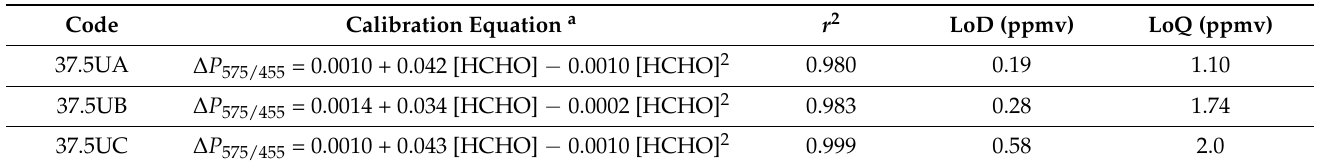
Table 1. Formaldehyde calibration equations, LoD and LoQ obtained from the corresponding dose- response curve for the sensing fibers coded